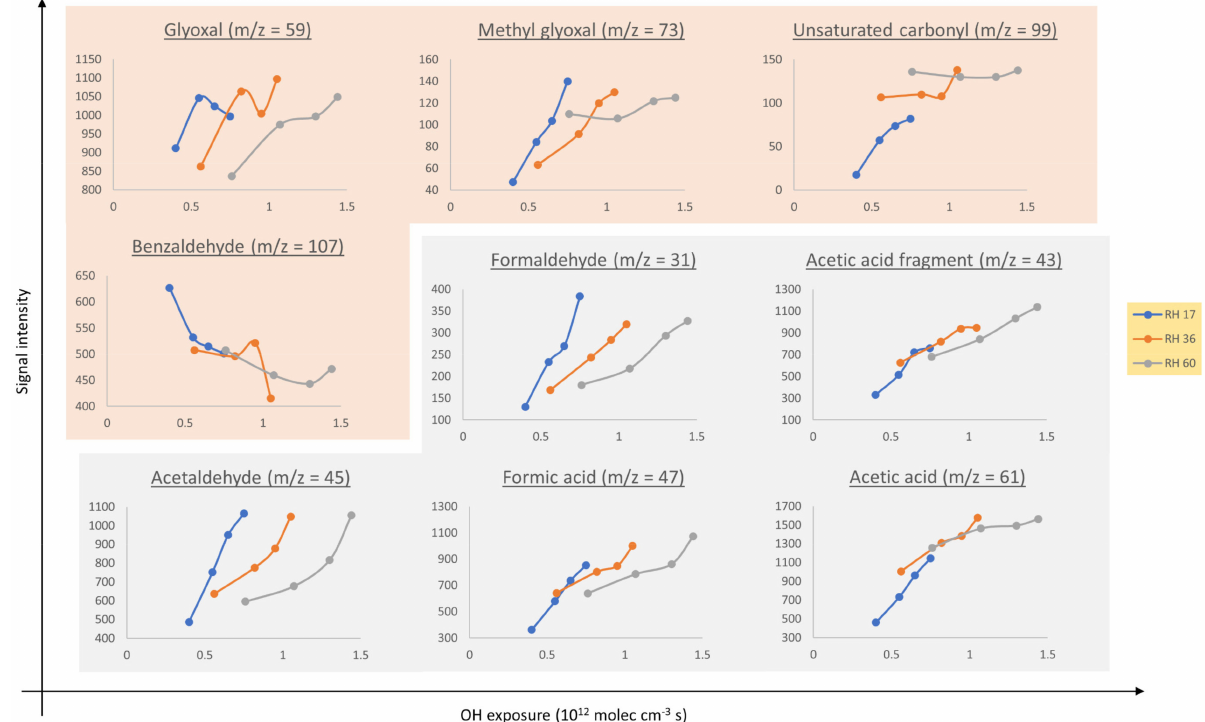
Figure 5. Changes in signal intensity of products observed by PTR-MS under different RH and OH exposure. Plots in light brown correspond to first generation products while plots in grey represents second generation